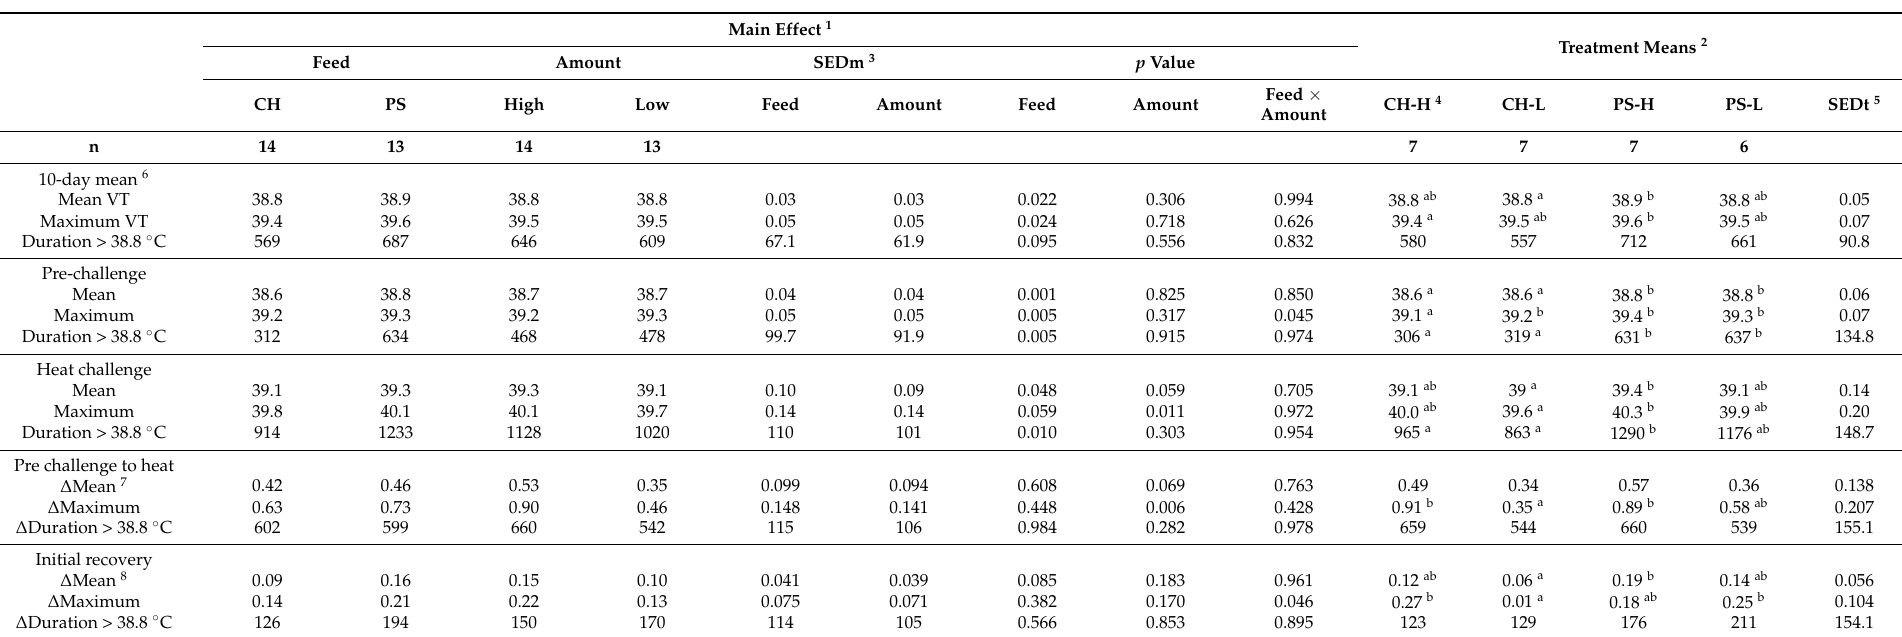
Table 7. Daily mean and maximum vaginal temperature (VT; ◦ C) and duration of vaginal temperature greater than 38.8 ◦ C (min/day) across the 10 days of measurement and during selected periods of the